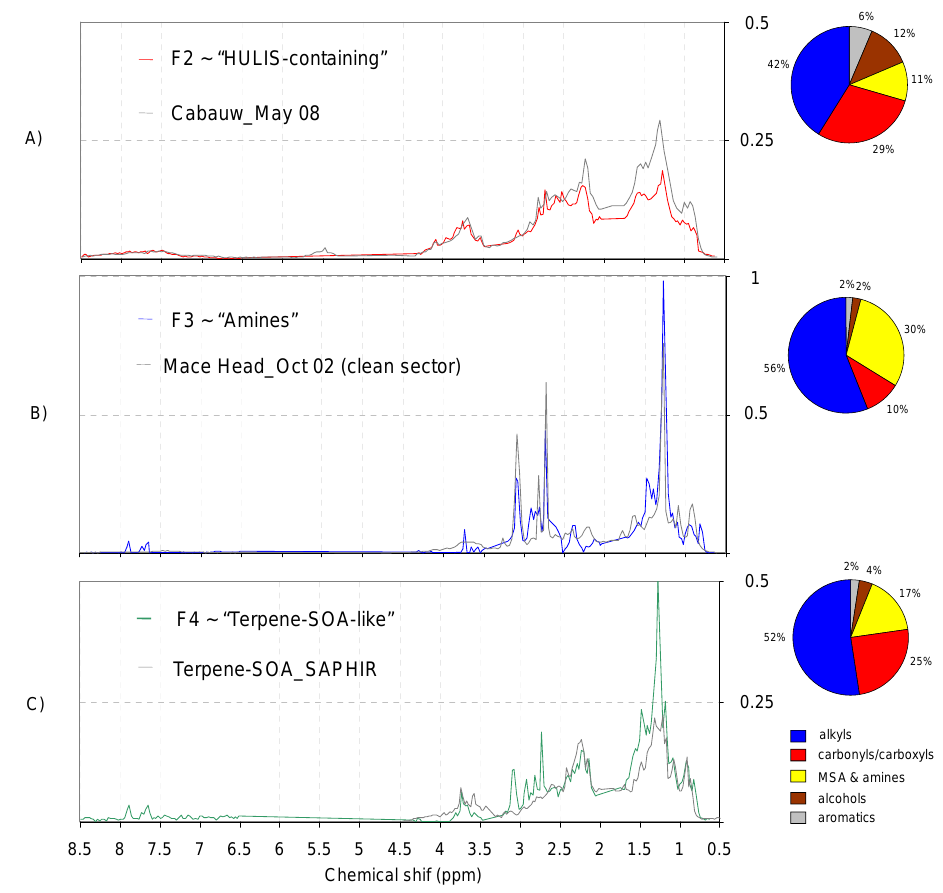
Fig. 10. NMR-factors profiles (MCR-ALS) emerging from the Hyyti¨al¨a dataset (coloured lines) overlapped with reference spectra (grey lines). The comparison includes spectral signatures obtained in other field (a), (b) and chamber (c) campaigns. The functional groups patterns (%) corresponding to each factor are reported on the